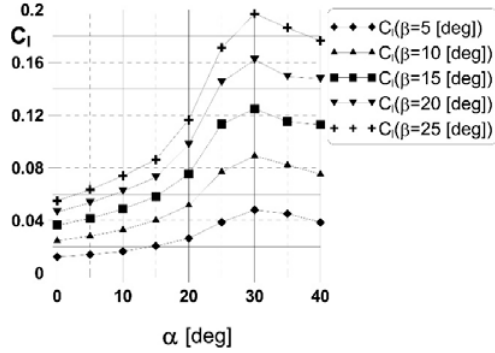
Fig. 12. Roll moment coefficient Cl versus angle of attack